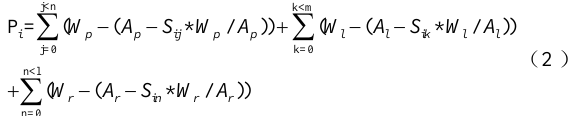
W , W = the max weight of corner point, straight W , l r p line and orthogonal angle A = the maximum radiation distance of r corner point, straight line and orthogonal angle S , S = the distance between current pixel and S , ik in ij corner point j , straight line k and orthogonal angle